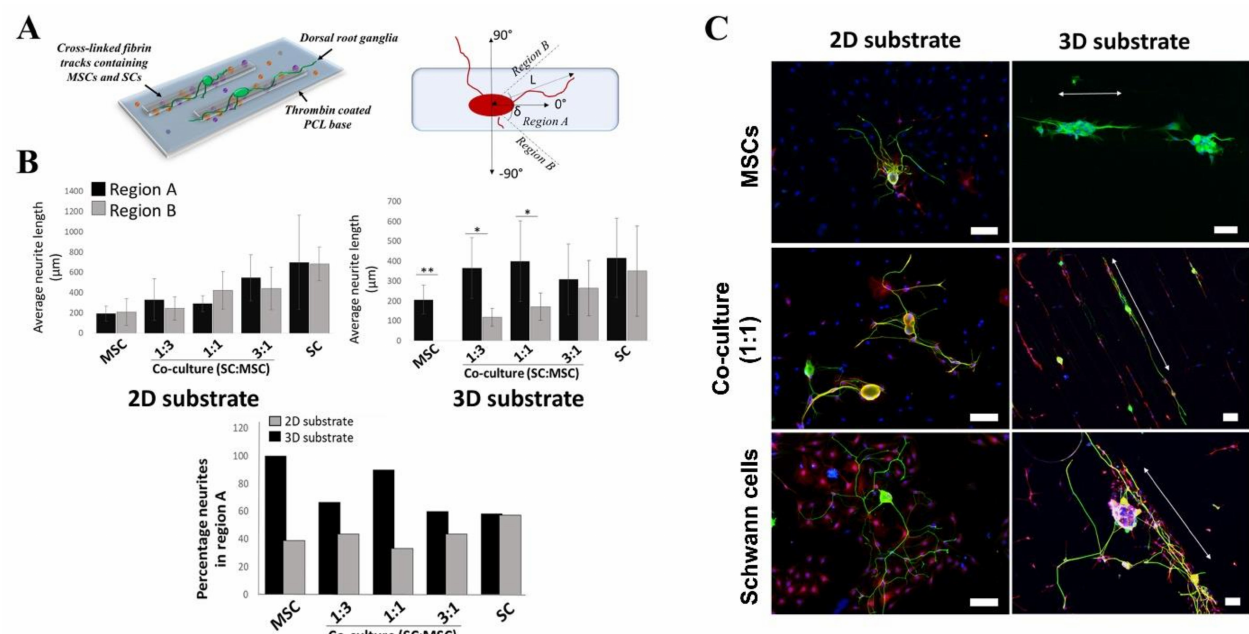
Figure 4. ( A ) Schematic illustrating printing of the 3D fibrin substrate onto PCL and orientation measurements: the angle ( δ ) was measured between the cell soma center and the distal end of the neurite. ( B ) Average lengths of primary DRG neurites on flat (2D) and printed (3D) substrates. Lengths are shown for neurites that fall within region A ( δ up to 45 ◦ ) and neurites that fall within region B ( δ between 45 and 90 ◦ ). ( C ) Fluorescence staining of DRG neurons and Schwann cells (SCs). SCs were stained for S100 (red) and used to highlight spatial organization and the population of printed cells. DRG neurons were stained for β III-tubulin (green) and cell nuclei with DAPI (blue). The white arrows in the 3D substrate column indicate the direction of the printed fibrin track. Error bars are standard deviations from the mean; * indicates a significant difference between groups where p < 0.05, ** p < 0.01; n ≥ 10. All scale bars are 100 µ